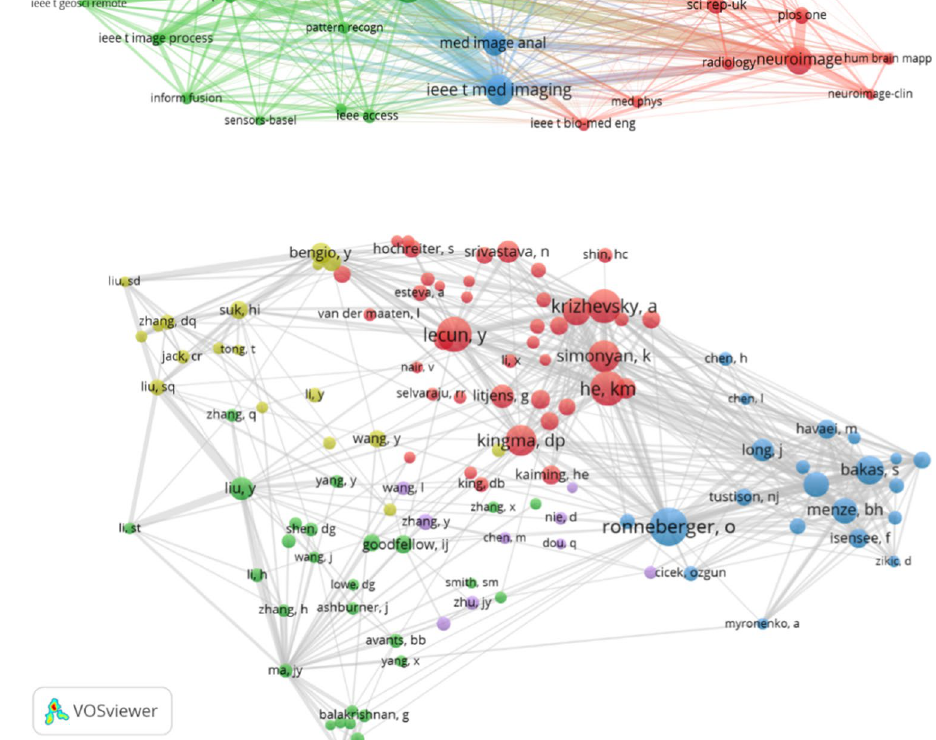
network of MMDLM-related publications